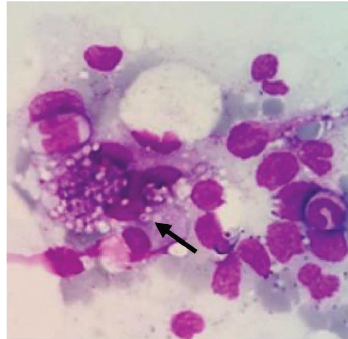
Figure 2: Bone marrow aspiration after 4weeks of antifungal treatment showed the reduction of intracellular budding yeast of Histoplasma inside the macrophages.